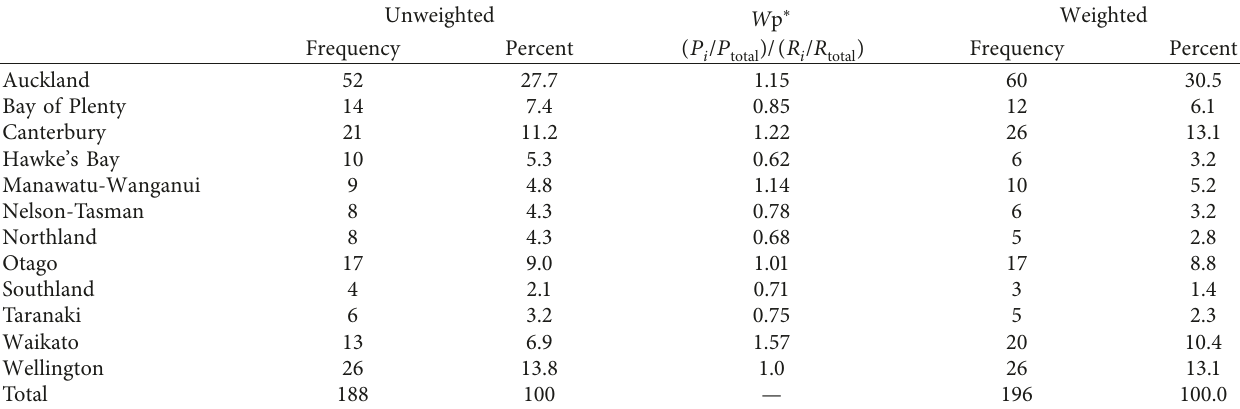
Table 1: Proportional weight calculation with respect to New Zealand regions.